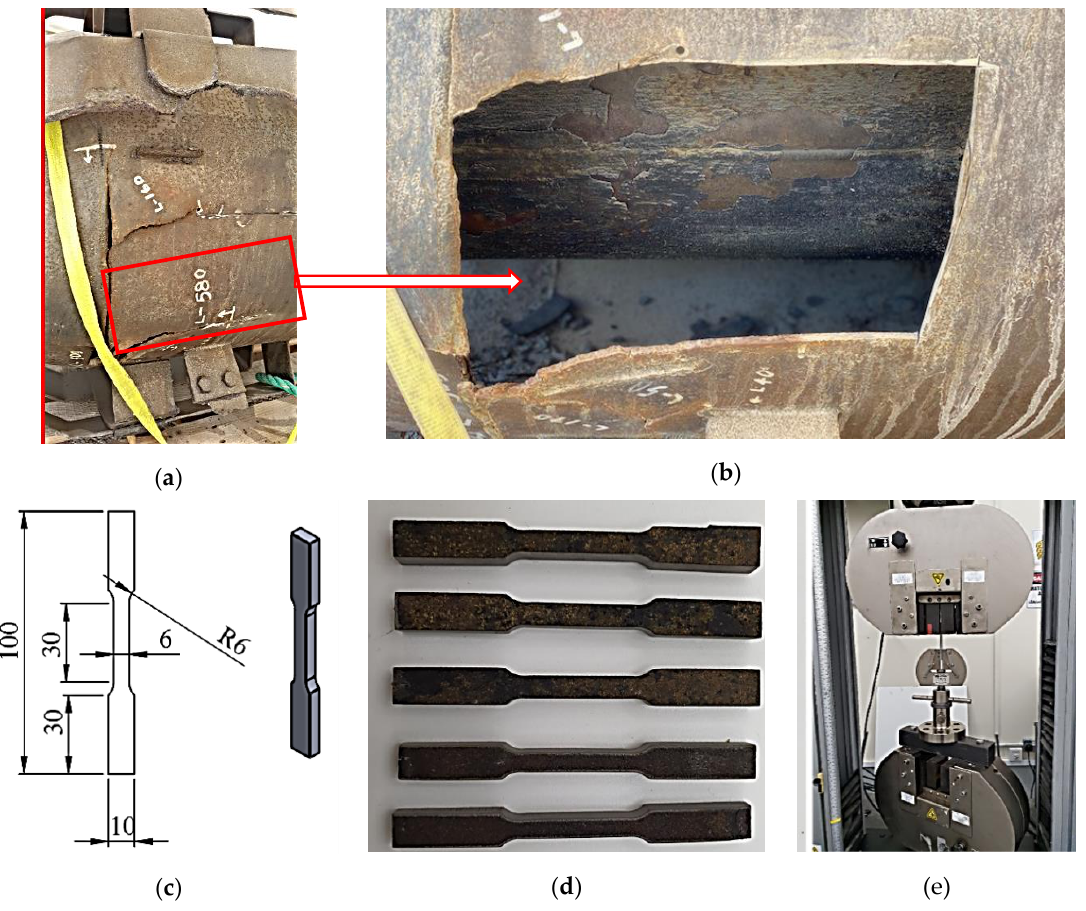
Figure 4. Specimen preparation for tensile test: ( a ) The flare tip region where the plate was cut. ( b ) The flare tip after the plate was removed. ( c ) The dimensions of the tensile test specimen. ( d ) The machined tensile test specimens. ( e ) Tensile test setup.